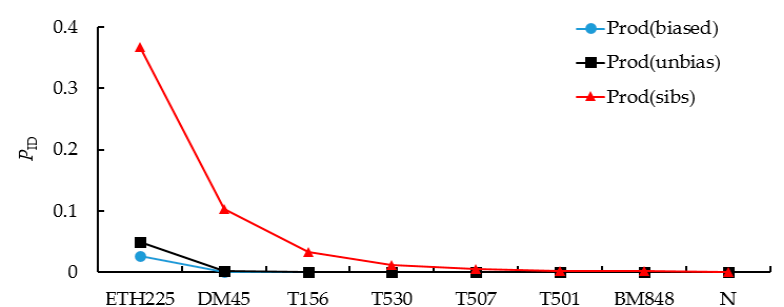
Figure 2. The probability of identity ( P ID ) curve generated eight microsatellite loci. Table 2. Information about the feces sample of red deer.